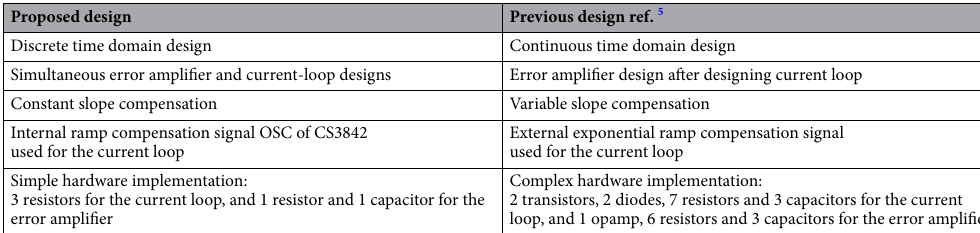
Table 2. Comparison between proposed and previous current-mode controller